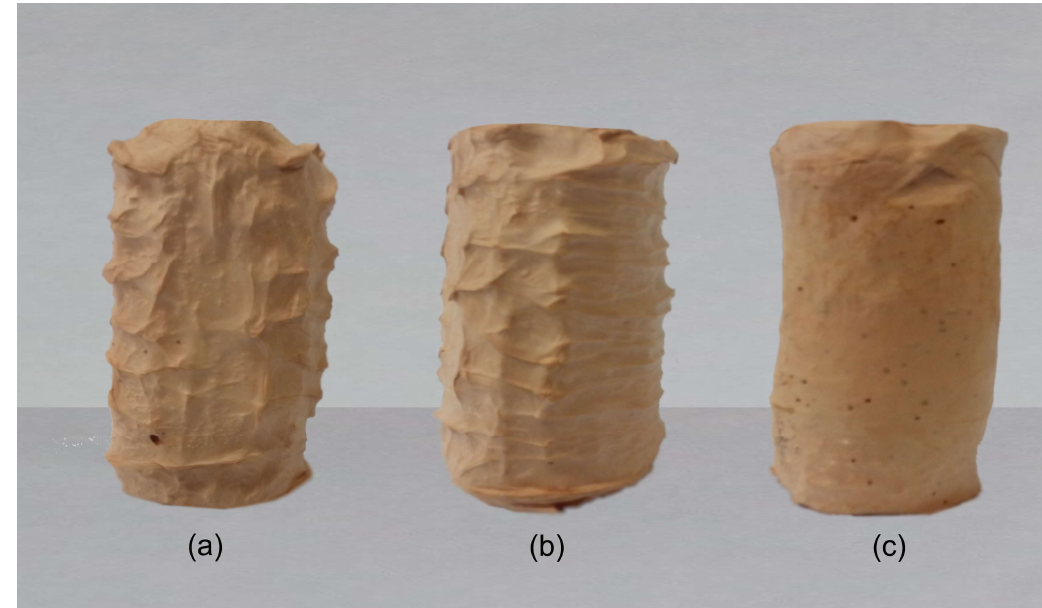
Figure 6. Image of the 3D scaffold: ( a ) without wall; ( b ) with thin wall; and ( c ) control specimen after electrospinning.